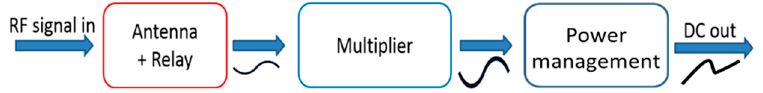
Figure 7. Block diagram of step-up converter and power manager for energy harvesting application.